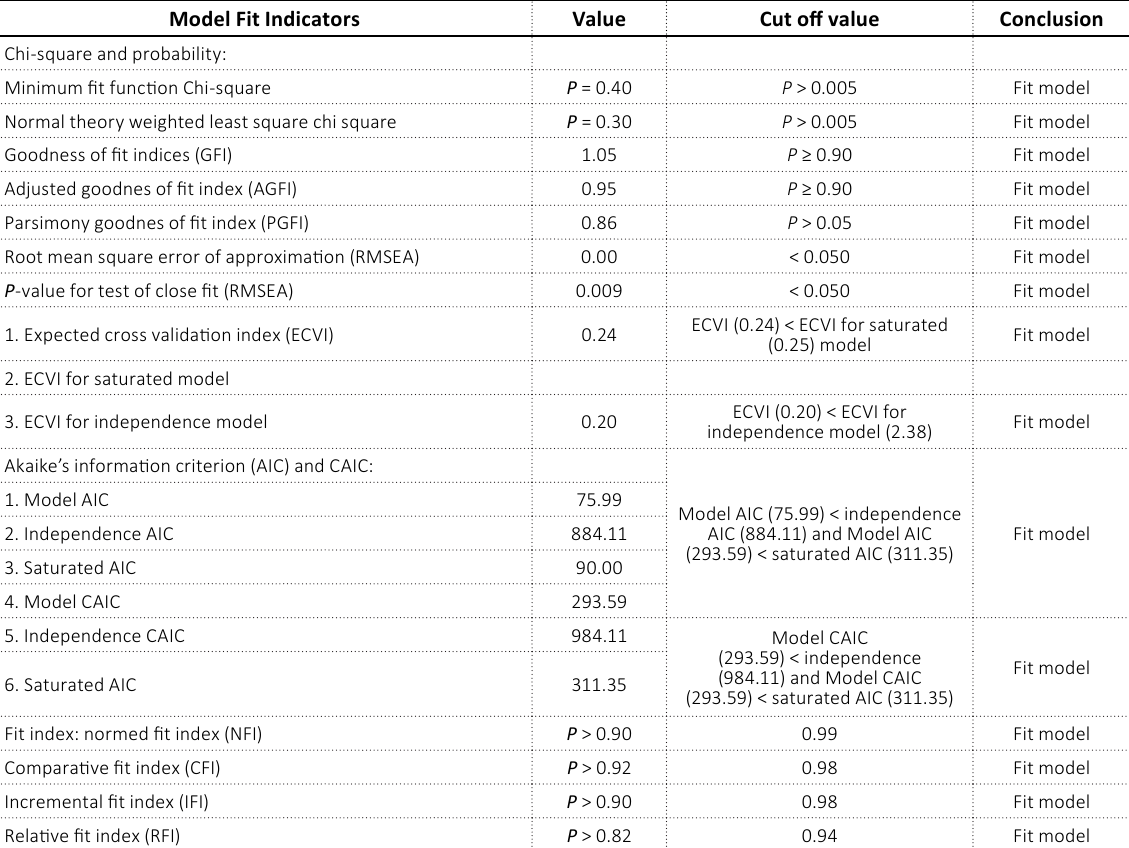
Table 2. The results of goodness-of-fit